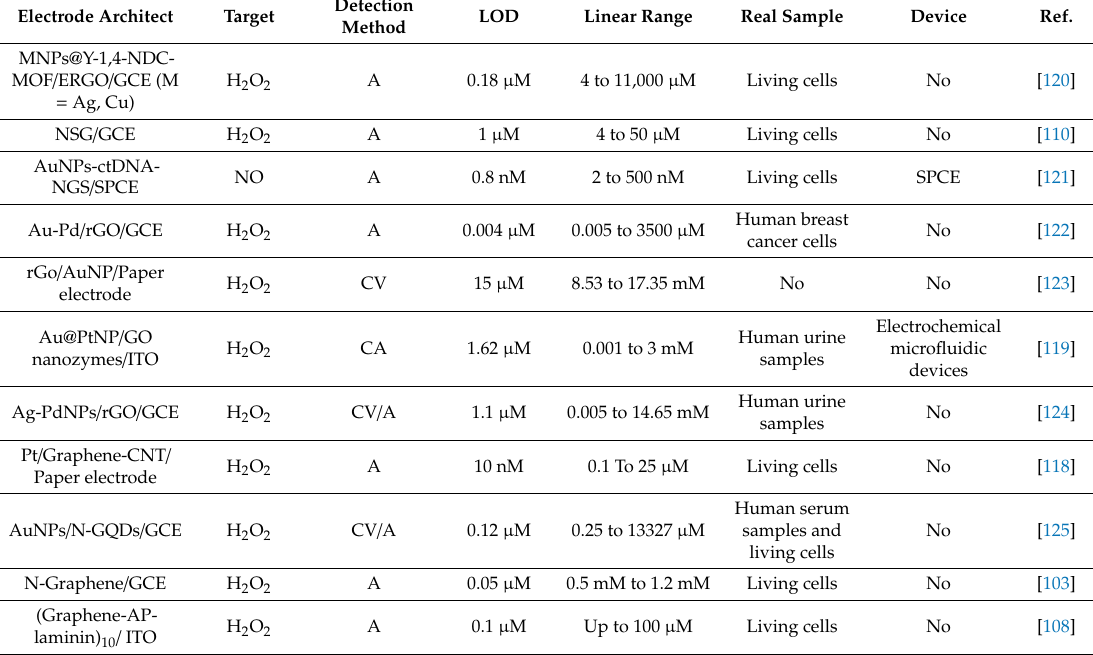
Table 3. Reported literature for graphene-based chemosensors for electrochemical detection of NO and H 2 O 2